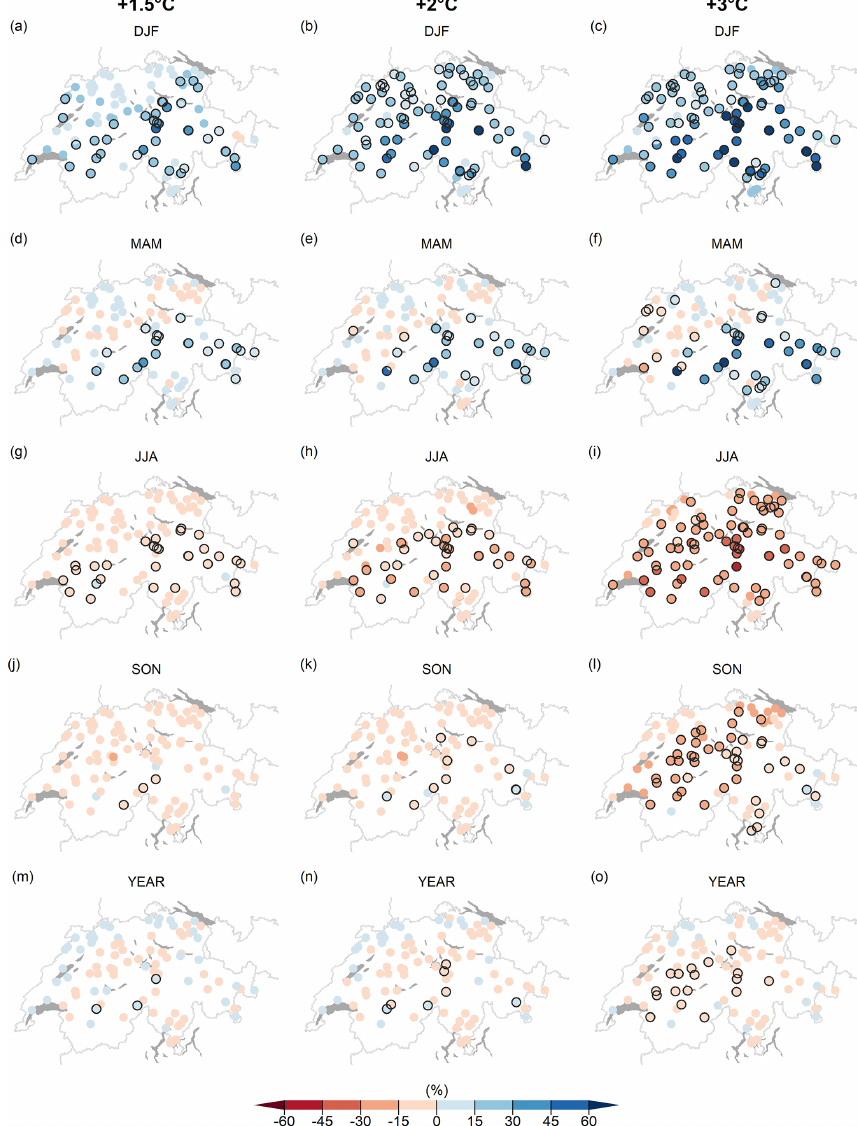
Figure 8. Multimodel median of seasonal and annual mean changes of runoff due to + 1 . 5 ◦ C (a, d, g, j, m) , + 2 ◦ C (b, e, h, k, n) , and + 3 ◦ C global warming for winter (a–c) , spring (d–f) , summer (g–i) , autumn (j–l) , and year (m–o) . Black circles indicate catchments whose direction of change agrees across at least 90% of the